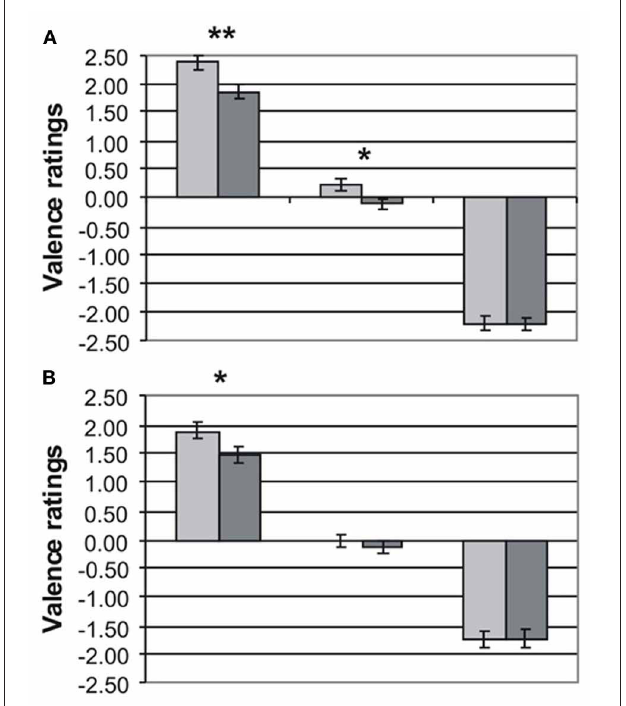
FIGURE 1 | Rating (mean values ± standard errors of the mean) of emotional prosody (A) and emotional word content (B) obtained in healthy controls (light gray) and depressed patients (dark gray) for positive (left bars), neutral (center bars), and negative (right bars) emotional information. ∗ p < 0 . 05 ∗∗ p < 0 .